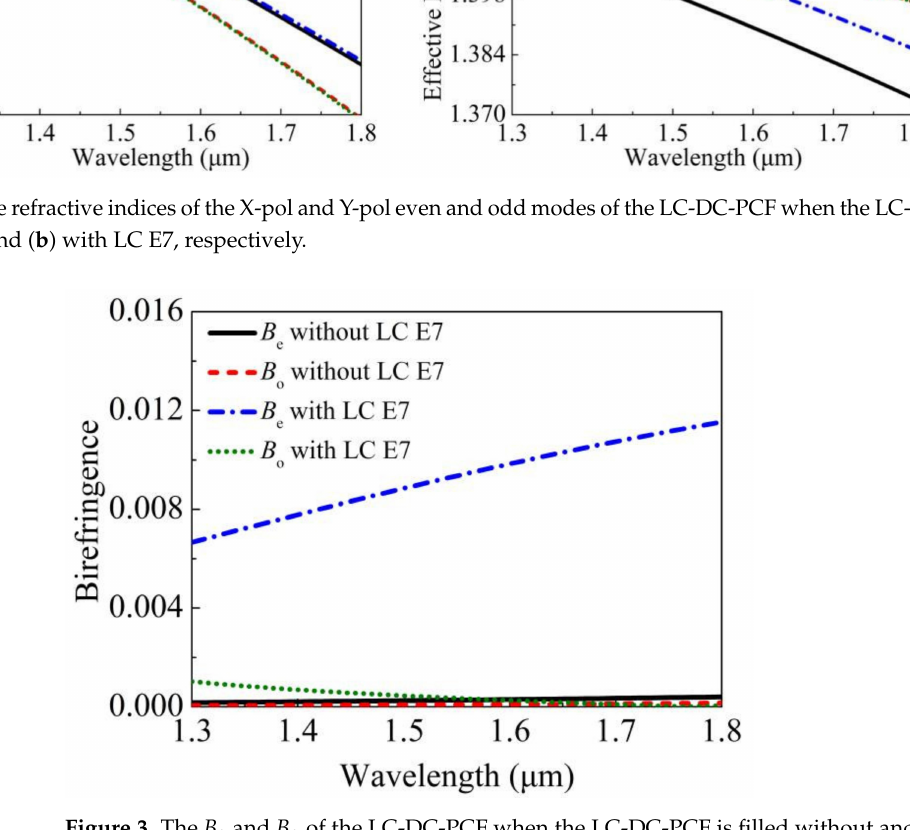
Figure 3. The B e and B o of the LC-DC-PCF when the LC-DC-PCF is filled without and with LC